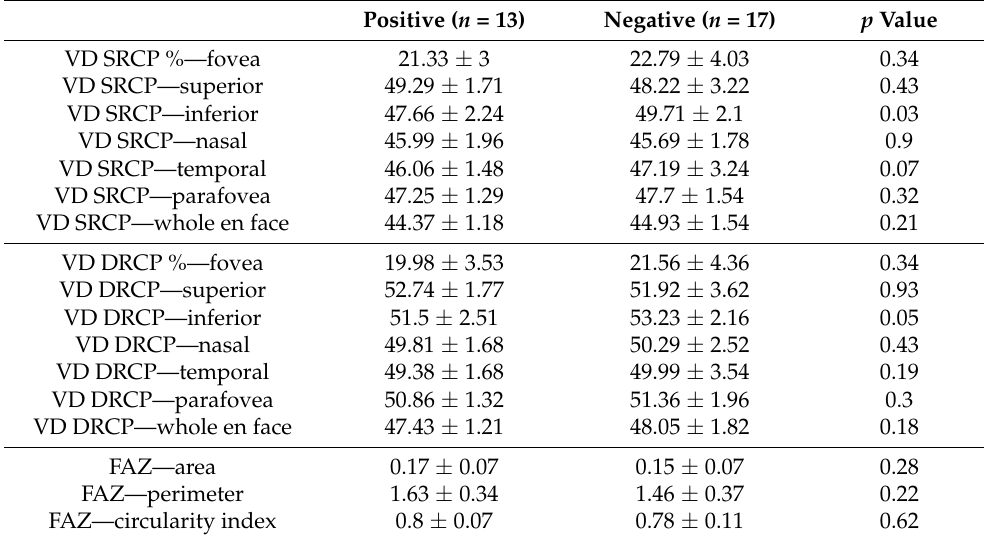
Table 5. Comparison of OCTA parameters among SLE patient using Methotrexate.